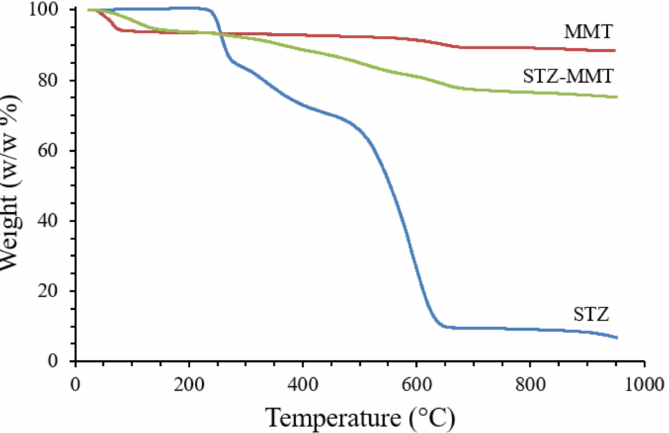
Figure 3. TGA profiles of STZ, MMT and STZ-MMT.